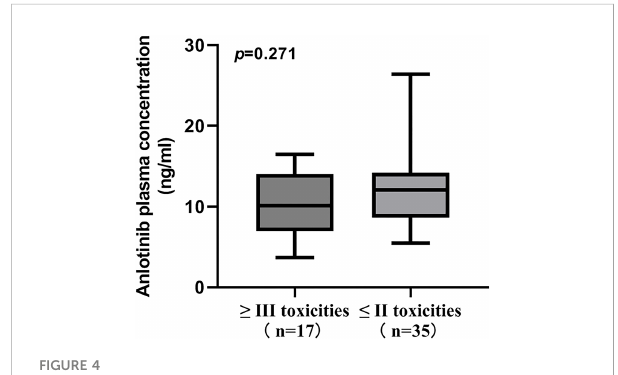
FIGURE 4 Comparison of ANL C trough between patients with grade ≥ III toxicities and grade ≤ II